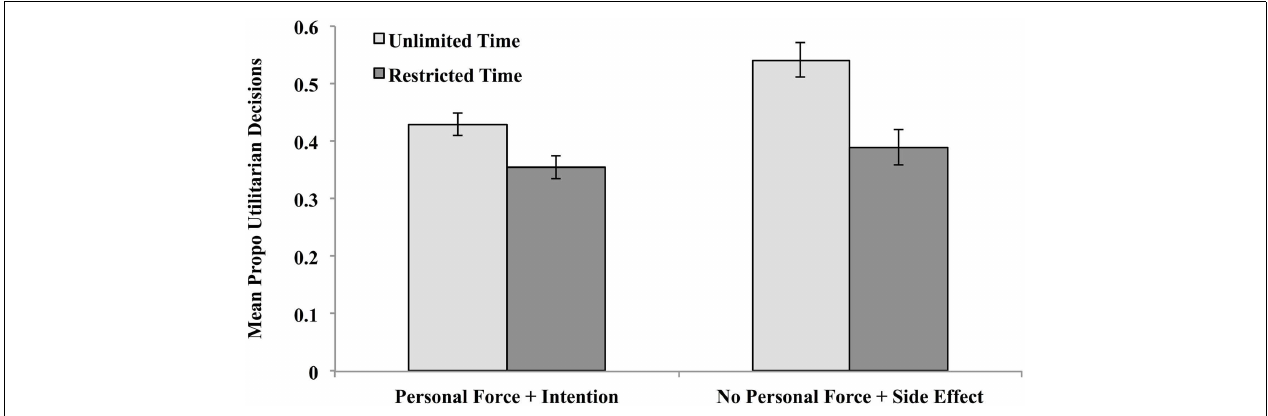
FIGURE 3 | Proportion utilitarian (“Yes”) decisions made as a function of decision time (unlimited or reduced) for vignettes that involve the use of personal force to intentionally produce harm and for vignettes that do no involve the use of personal force but yield harm as an unintended side effect in Experiment